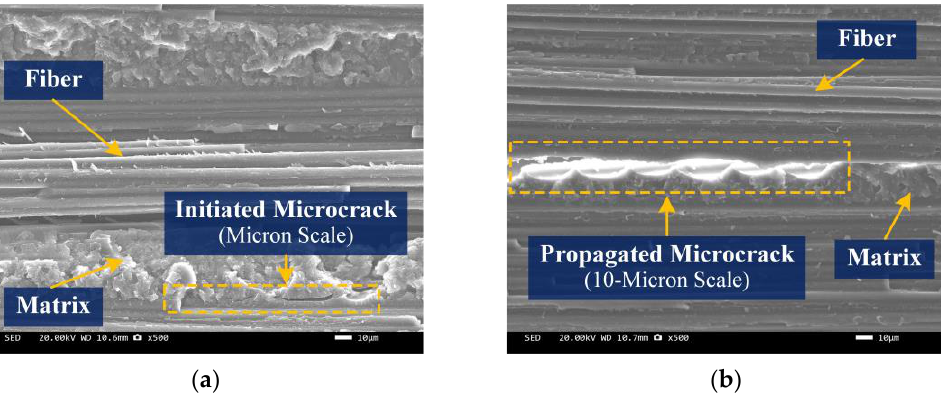
Figure 8. SEM images in different locations of the fracture cross-section of sample: ( a ) microcrack initiation; ( b ) microcrack propagation.